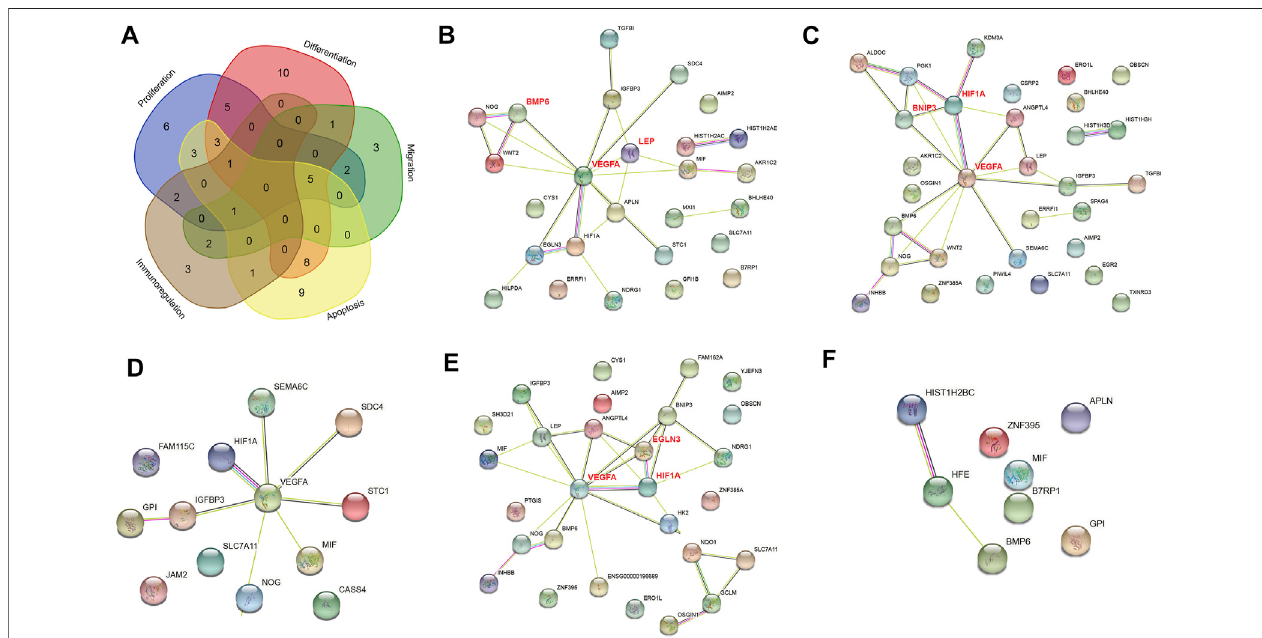
FIGURE 2 | PPI networks of differentially expressed genes (DEGs) in normoxia-treated healthy hPDLSCs (H_N) compared with hypoxia-treated healthy hPDLSCs (H_H). (A) Venn diagram of DEGs associated with proliferation, differentiation, migration, apoptosis, and immunoregulation. PPI networks of DEGs associated with proliferation (B) ,differentiation (C) , migration (D) , apoptosis (E) , and immunoregulation (F) .The genesin bold red arethe three hub geneswith thehighest correlationas identi fi ed by